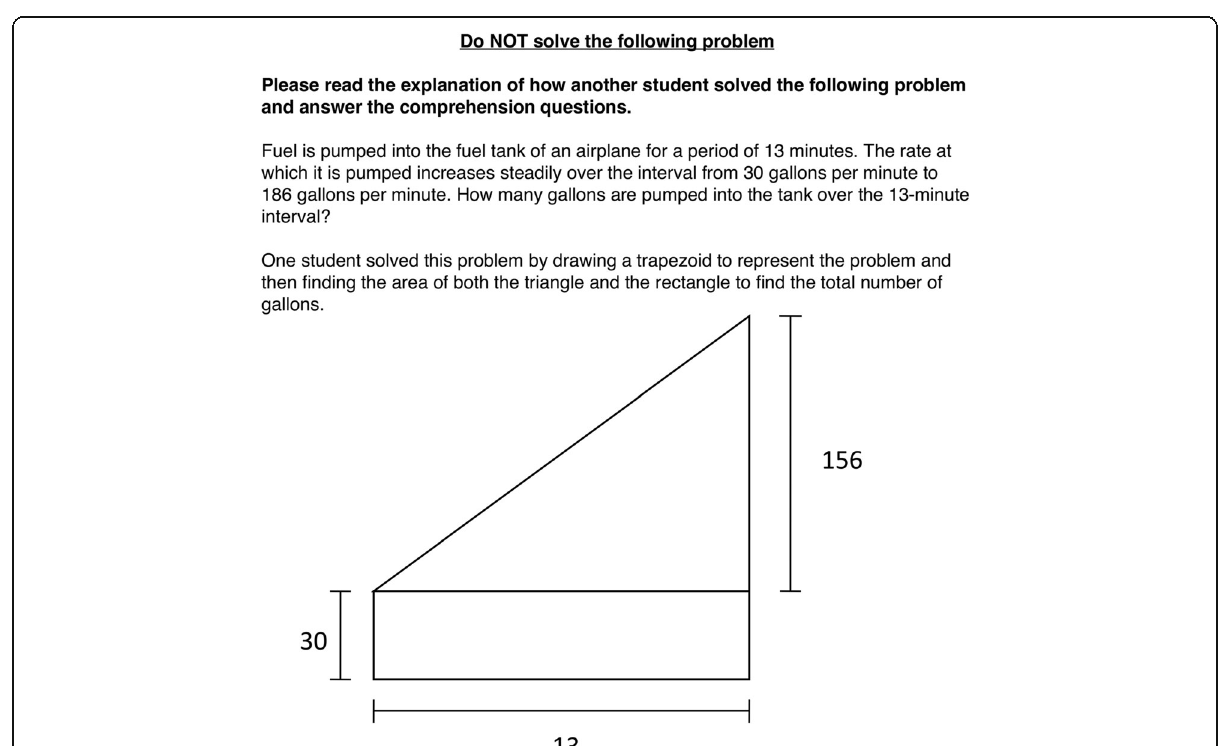
Fig. 1 Description of the target area strategy from the exposure section of the